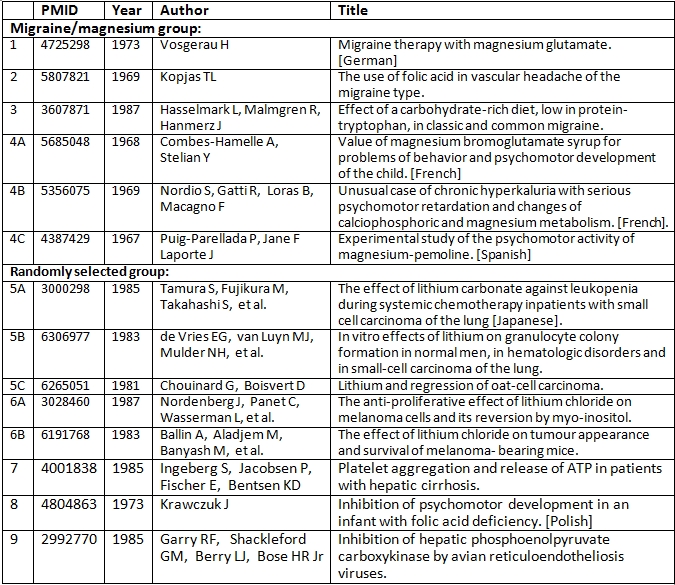
Authors and Titles